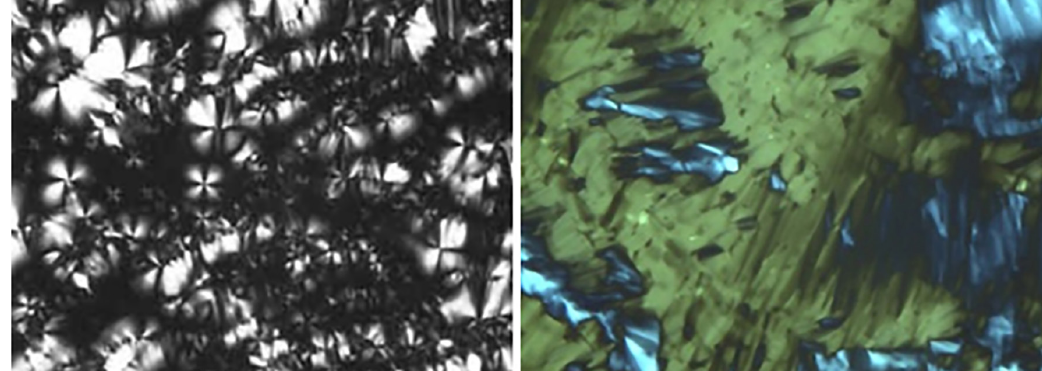
FIGURE 3 - Polarized light micrography of LCS: lamellar phase (left) and hexagonal phase (right). Magnification of 400 x.